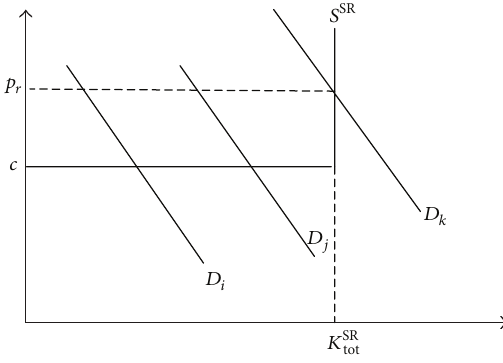
Figure 3: The energy system with only one